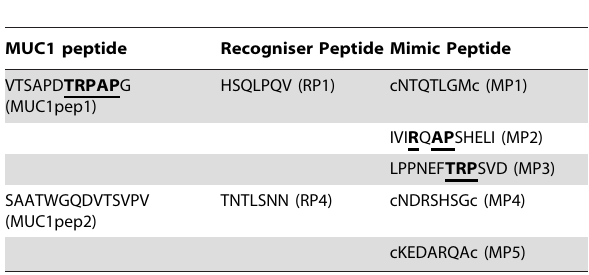
Table 3. MUC1 peptides, corresponding recognisers and putative mimic peptides.